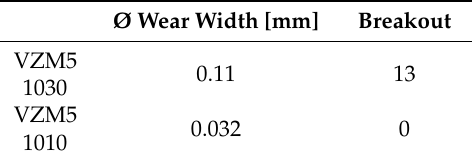
Table 21. Summary of tool wear after the hard machining tests, for inserts of type 1030 and 1010.